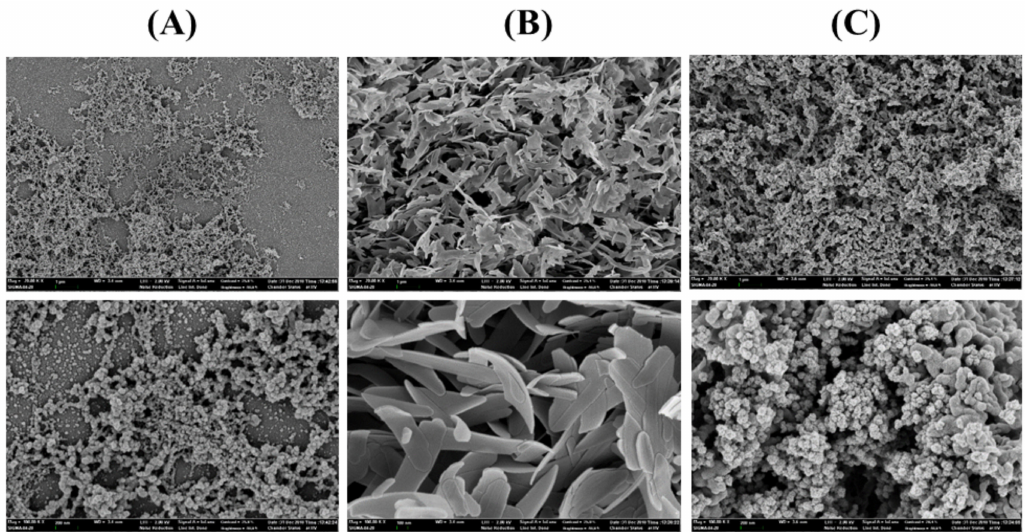
Figure 6. Immobilization of Ha HSL. Field emission scanning electron microscopic images of CLEA-Arg- Ha HSL ( A ), mCLEA-Arg- Ha HSL ( B ), and hNF- Ha HSL ( C ) were obtained at 50,000 × ( upper ) and 150,000 × ( lower ) magnifications.